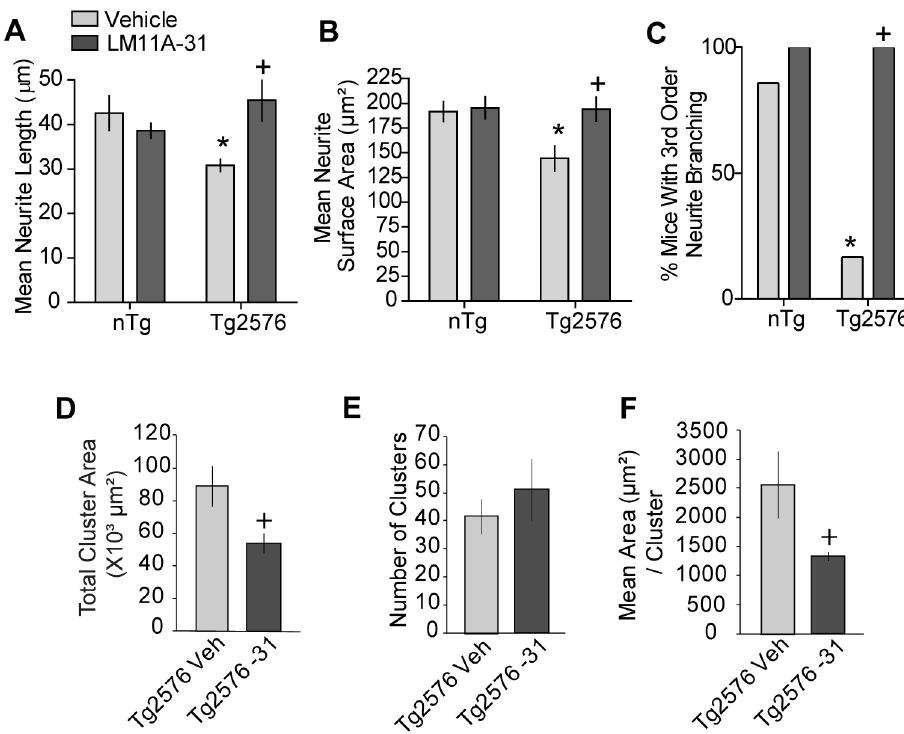
Figure 10. LM11A-31 prevents dystrophy of cholinergic neurites in mid- to late-stage female Tg2576 mice. Quantitative analysis showed that treating female Tg2576 mice starting at 14 months of age with LM11A-31 for 3 months prevented and/or reversed the decreases in ( A ) length, ( B ) surface area, and ( C ) branching of BFCN neurites. This treatment also decreased the total area ( D ) occupied by the clusters of cholinergic dystrophic neurites in the cortex and the mean area per cluster ( F ) but did not affect the number ( E ). Statistical significance was determined using an ANOVA with Dunnett’s post-hoc test for BFCN neurite degeneration, a 2 6 2 contingency table with a Fisher’s exact test for branching, and a two- tailed Student’s t-test for clusters (nTg-Veh, n=7 mice; Tg2576-Veh, n=6; Tg2576-31, n=5; nTg–LM11A-31, n=4). * p # 0.05 vs. nTg veh; + p # 0.05 vs. Tg2576-Veh.